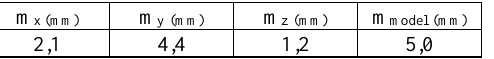
Table 2b. Accuracy analysis of 3D object model (Mirrorless